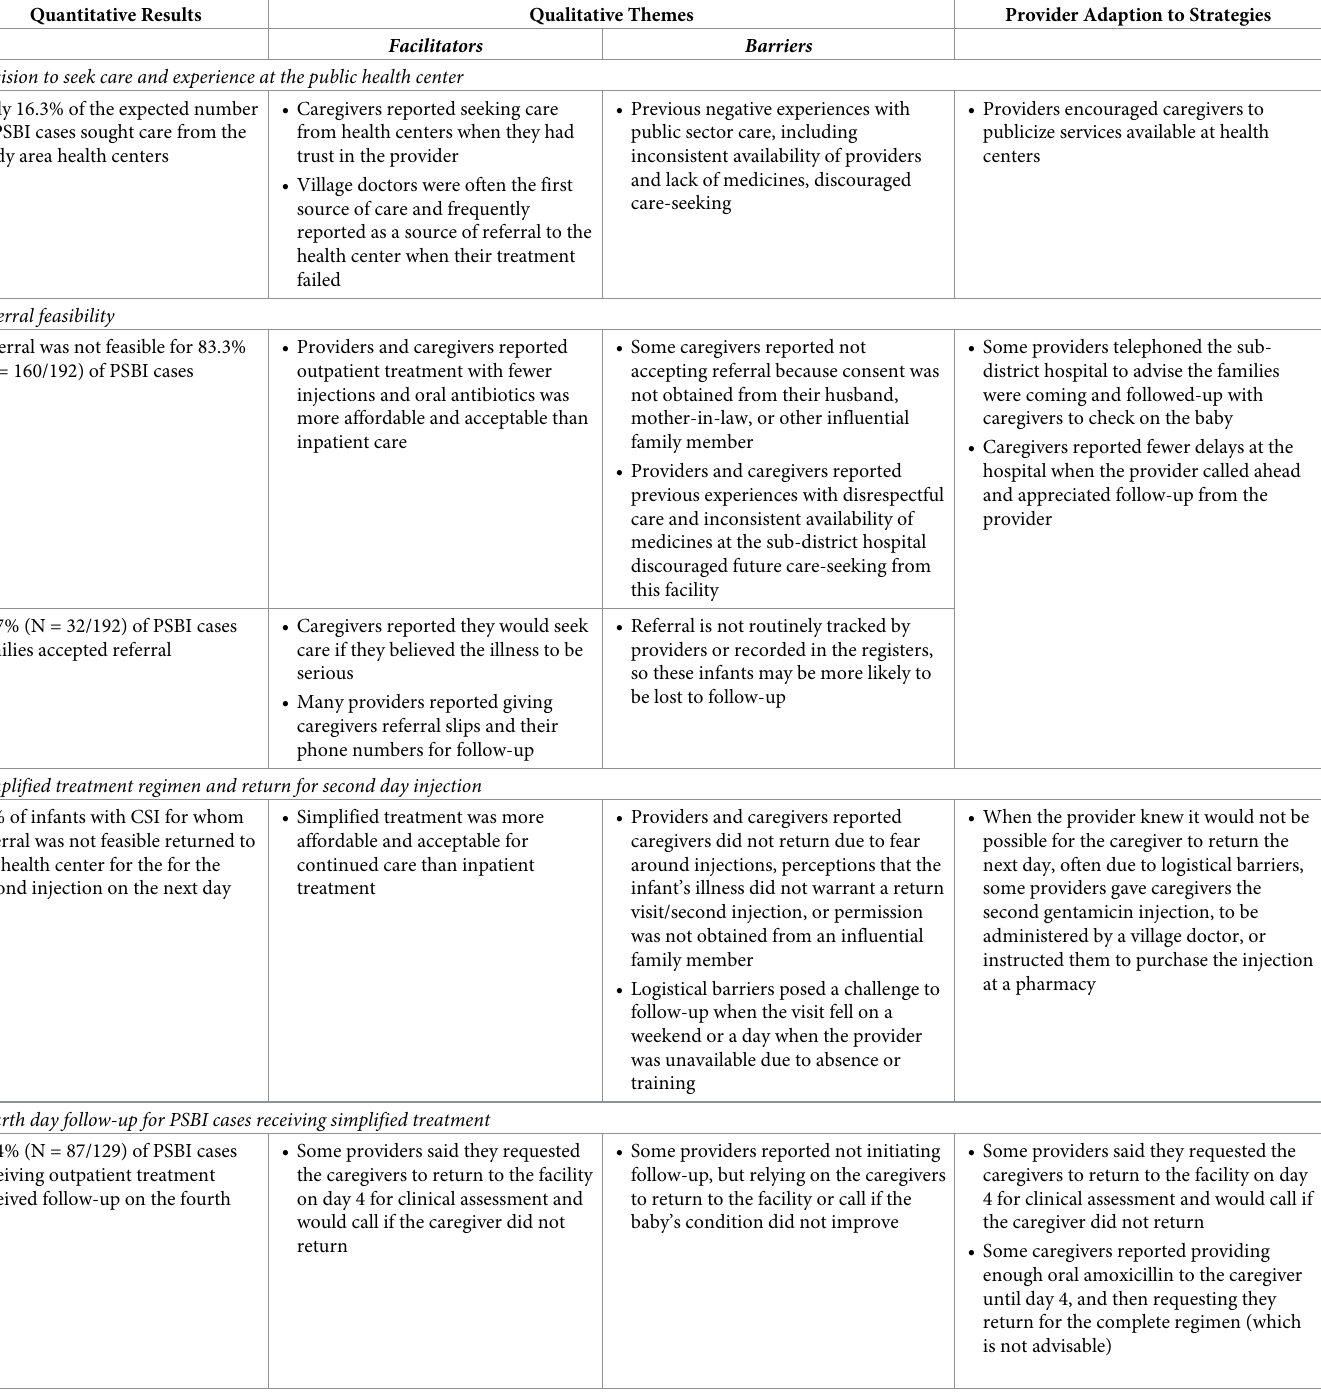
Table 2. Results of qualitative investigation into reasons for high and low values of caregiver acceptability for key components of the guidelines. Quantitative